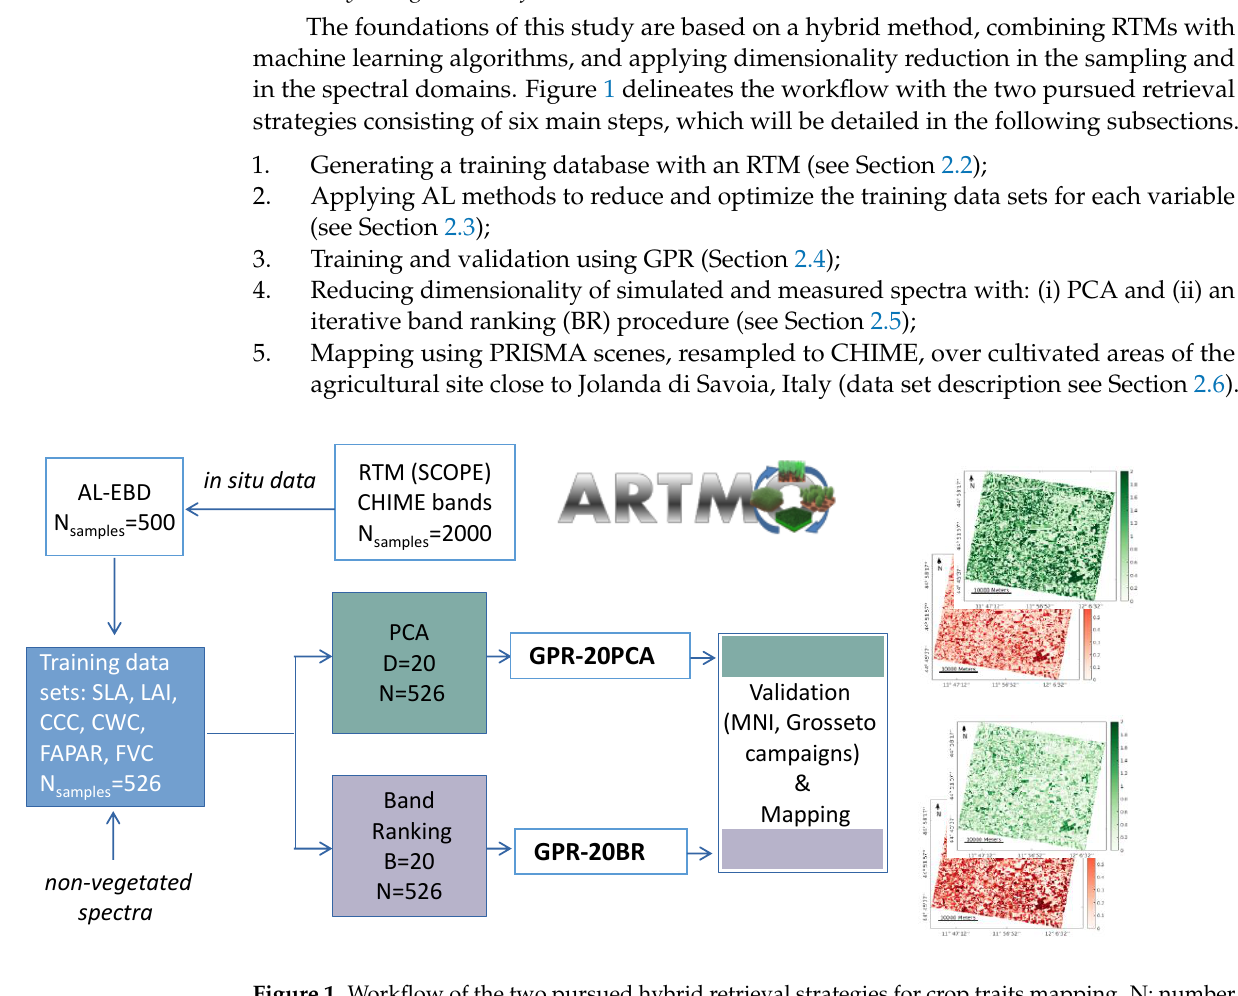
Figure 1. Workflow of the two pursued hybrid retrieval strategies for crop traits mapping. N: number of training samples (full pool, AL optimized), D: number of components, B: number of bands used for